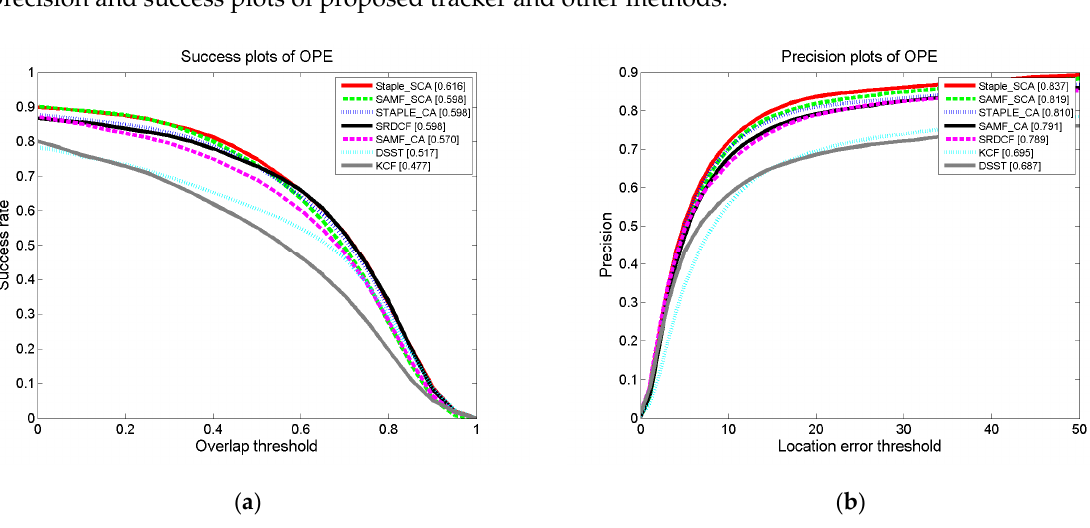
Figure 5. Success plots ( a ) and precision plots ( b ) of proposed tracker against five state-of-art trackers [15,17,19,20] on the 100 video sequences in Visual Tracking Benchmark [8].